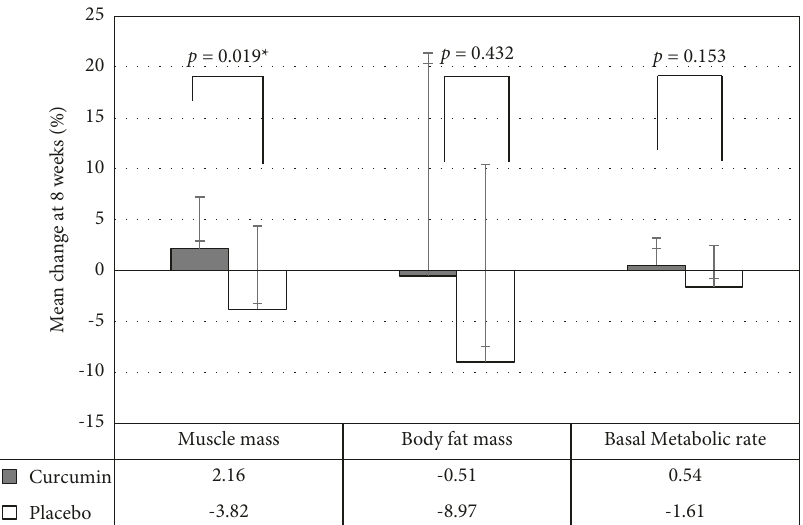
Figure 2: Comparison between the primary outcomes on the percentage of mean change of muscle mass, body fat mass, and basal metabolic rate between the curcumin and placebo groups. ∗ statistically significant ( p < 0 .